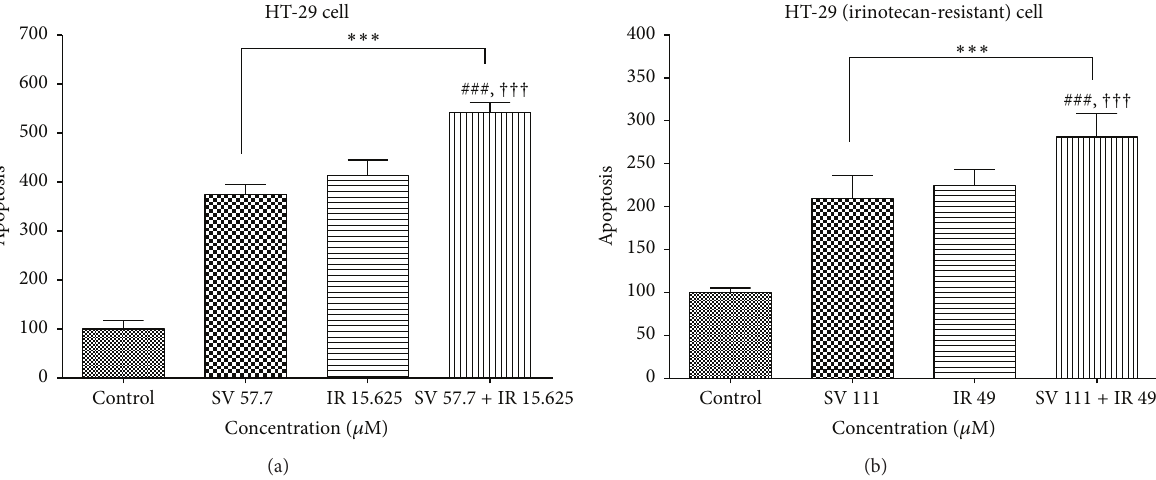
Figure 5: Synergistic effect of simvastatin and irinotecan on cell death in HT-29 cell and irinotecan-resistant HT-29 cells. Cell apoptosis was assessed by the detection of monooligonucleosomes (histone-associated DNA fragments) using an ELISA technique in HT-29 cells and HT-29R cells. (a) HT-29 cells were treated for 48 h with simvastatin (SV) alone, irinotecan (IR) alone, and combination of SV and IR at 2 :1 molar ratio in which the concentration of SV and IR was 57.7 𝜇 M and 15.625 𝜇 M, respectively. (b) HT-29R cells were treated for 48 h with SV alone, IR alone, and combination of SV and IR at 2: 1 molar ratio in which the concentration of SV and IR was 111 𝜇 M and 49 𝜇 M, respectively. Increased apoptotic responses were evident in combination treatment group of the cells relative to untreated control and single treatment of SV or IR in HT-29 cells and HT-29R cells. The data are expressed as the means ± SD from three independent experiments. ∗∗∗ 𝑃 < 0.001 , compared to untreated control cells. ∗∗∗ 𝑃 < 0.001 , compared to untreated control cells; ### 𝑃 < 0.05 , compared to SV alone; ††† 𝑃 < 0.05 , compared to IR alone.